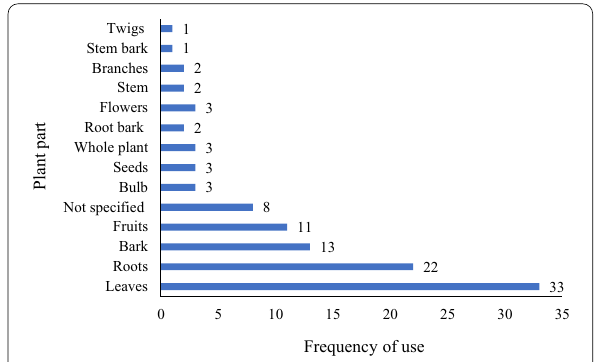
Fig. 1 Frequency of the reported plant parts used for blood purification, cleansing, detoxification or strengthening in East Africa